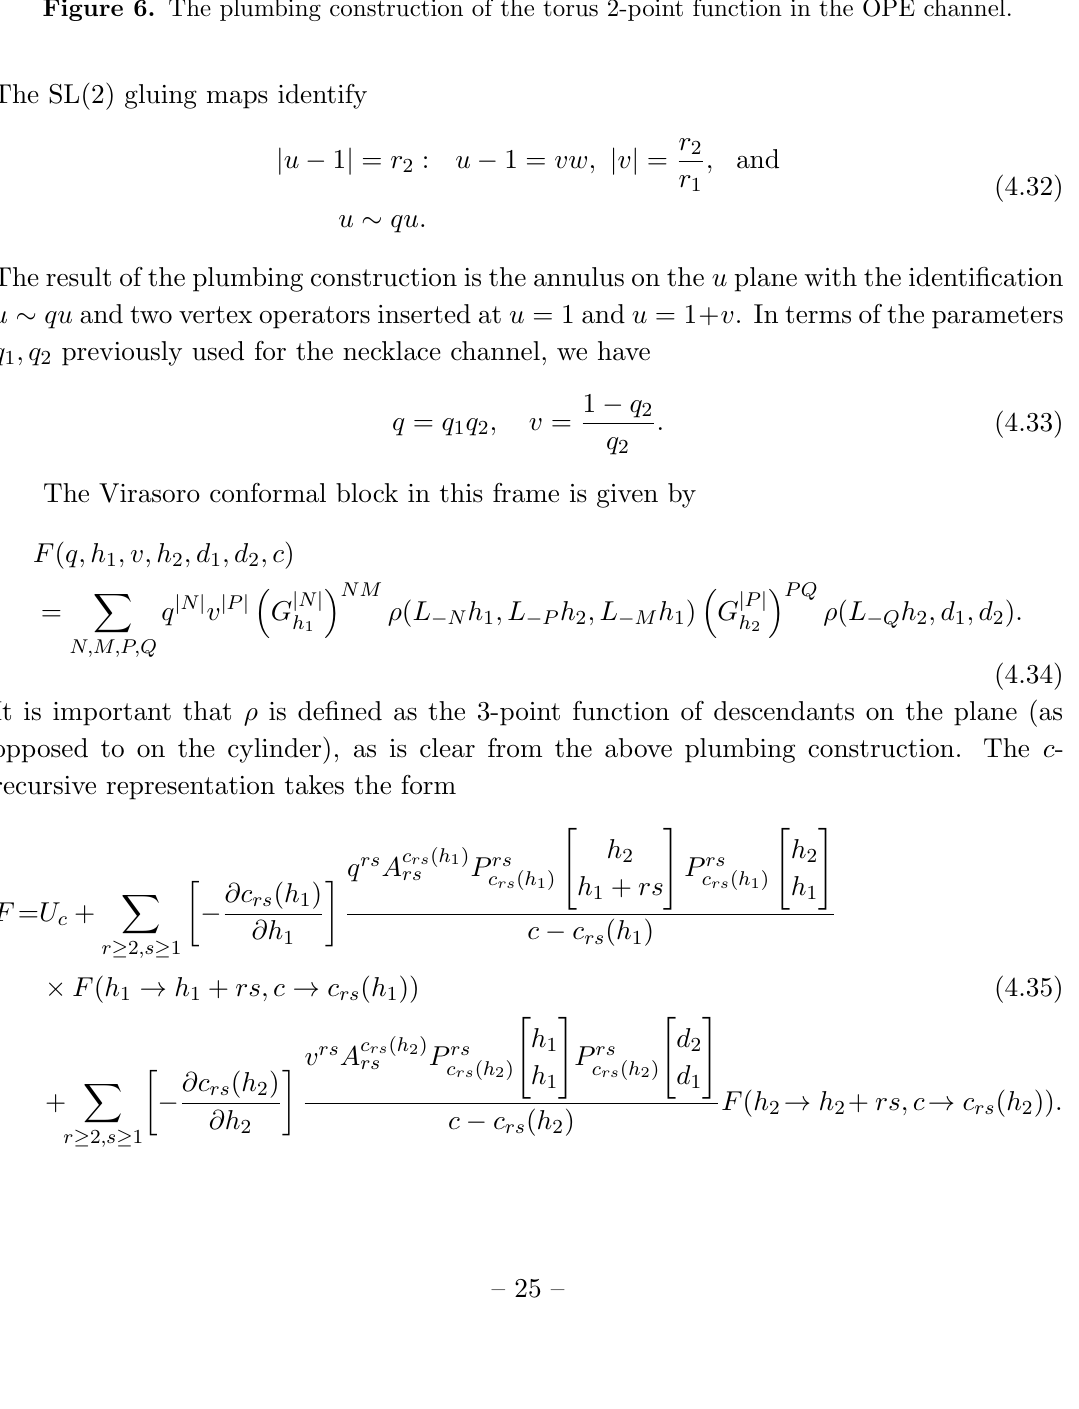
Figure 6. The plumbing construction of the torus 2-point function in the OPE